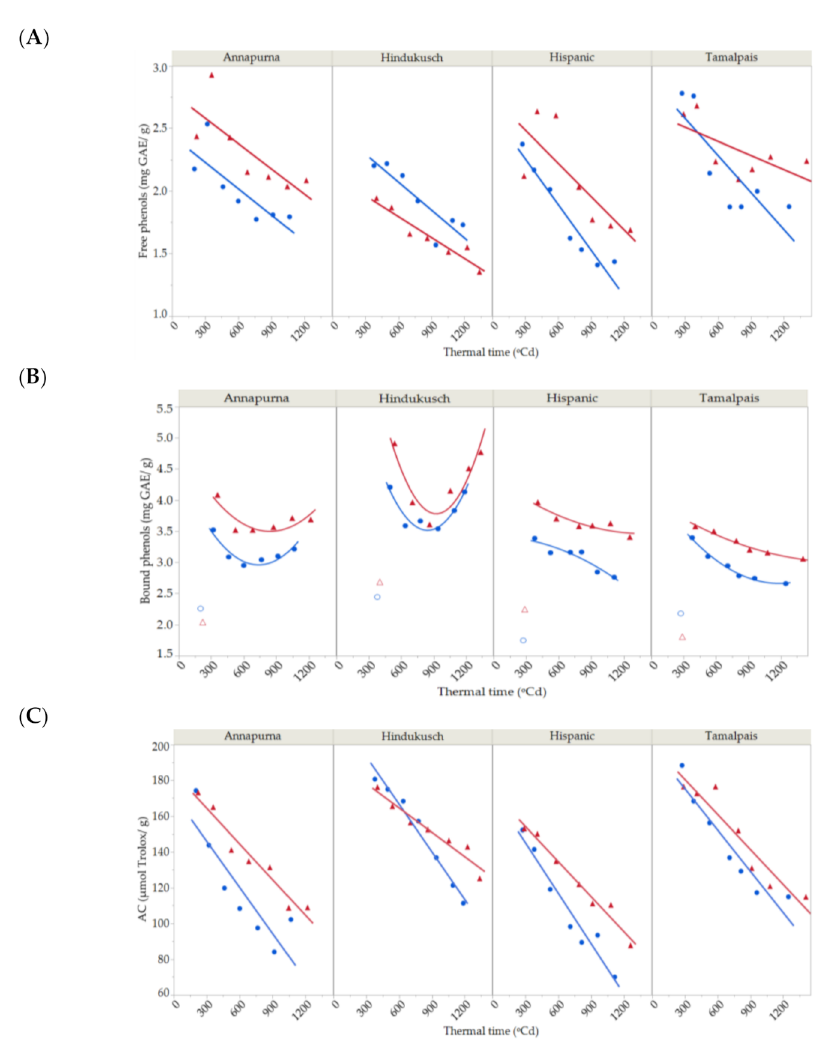
Figure 4. Dynamics of free ( A ), bound ( B ) phenolic compound content and ( C ) antioxidant capacity during grain filling for four barley genotypes in 2018 under control (blue circles) and thermal stress conditions (red triangles). Solid lines represent the best fit (first- and second-degree polynomial curve for free and bound phenolic compounds and first-degree for antioxidant capacity. Total R 2 = 81.19% and R 2 = 96.65%, R 2 = 93.45%, respectively).